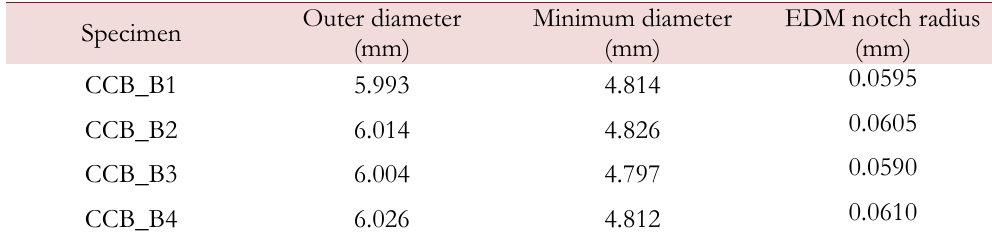
Table 3: Specimen dimension. Tensile